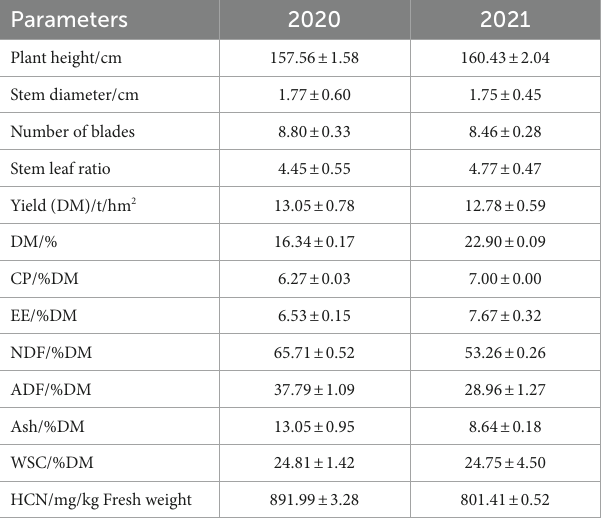
heading and flowering stages, with plant height reaching 157.56 cm,